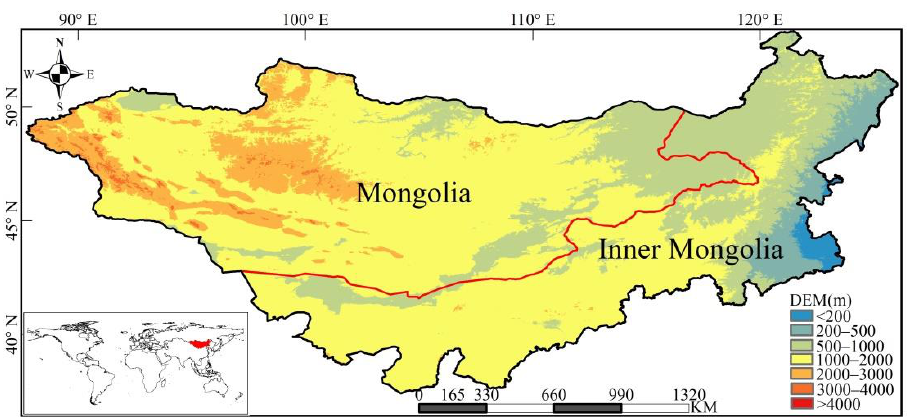
Figure 1. Geographical location and elevation in the Mongolian Plateau.